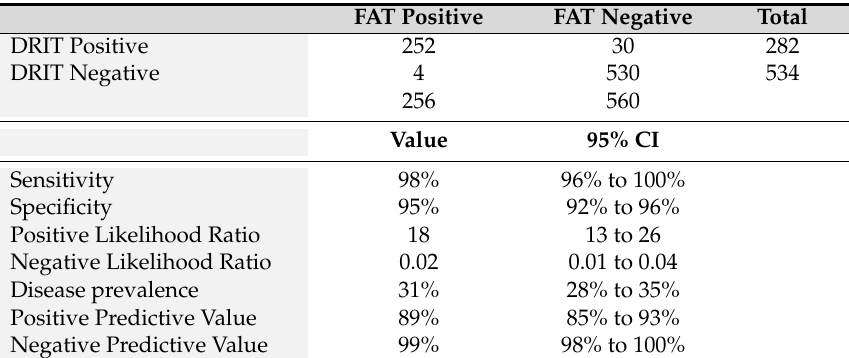
Table 2. DRIT mab cocktail diagnostic performance, as compared to the FAT, determined on 816 animal brain samples (Table 1).